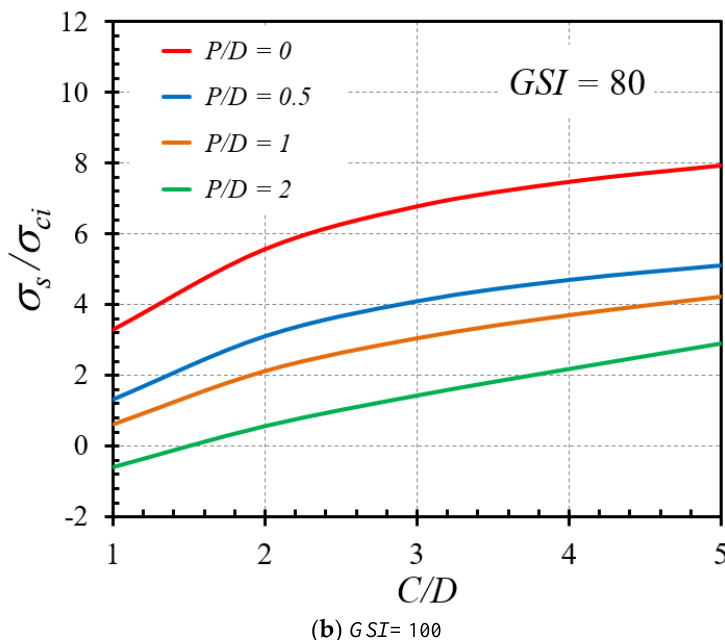
Figure 11. Impact of C/D on the stability solutions of tunnel headings ( γ D/ σ ci = 0 and m i = 5).